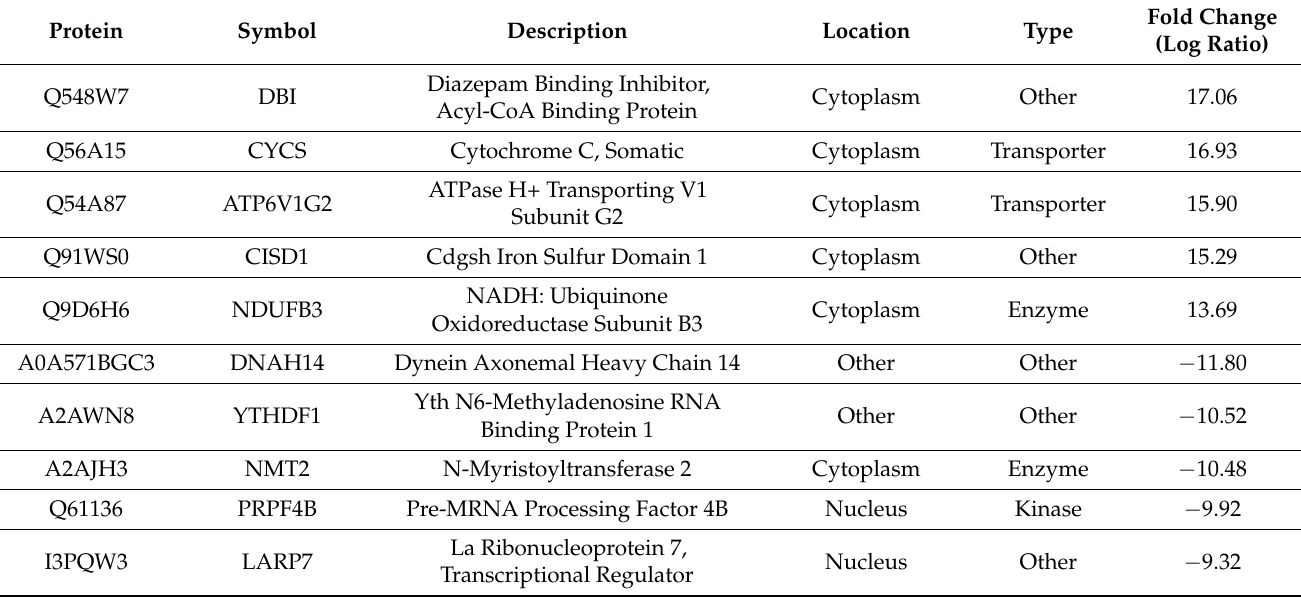
Table 1. Top upregulated and downregulated proteins associated with TAC treatment compared to DMSO treatment.